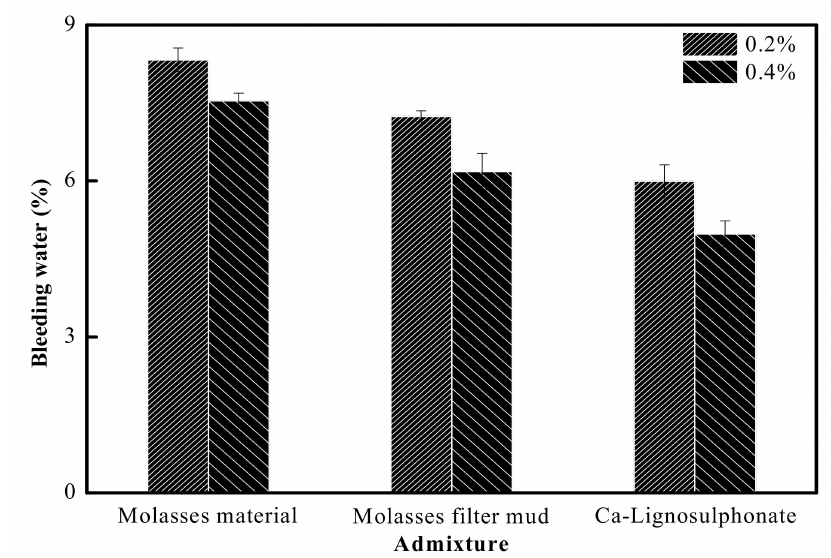
Figure 2. Effects of different additives on the total bleeding water of fresh